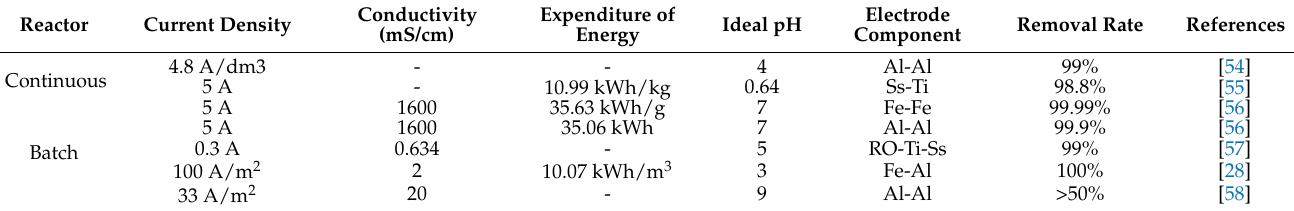
Table 3. Different electrocoagulation techniques for removing Cu(II).